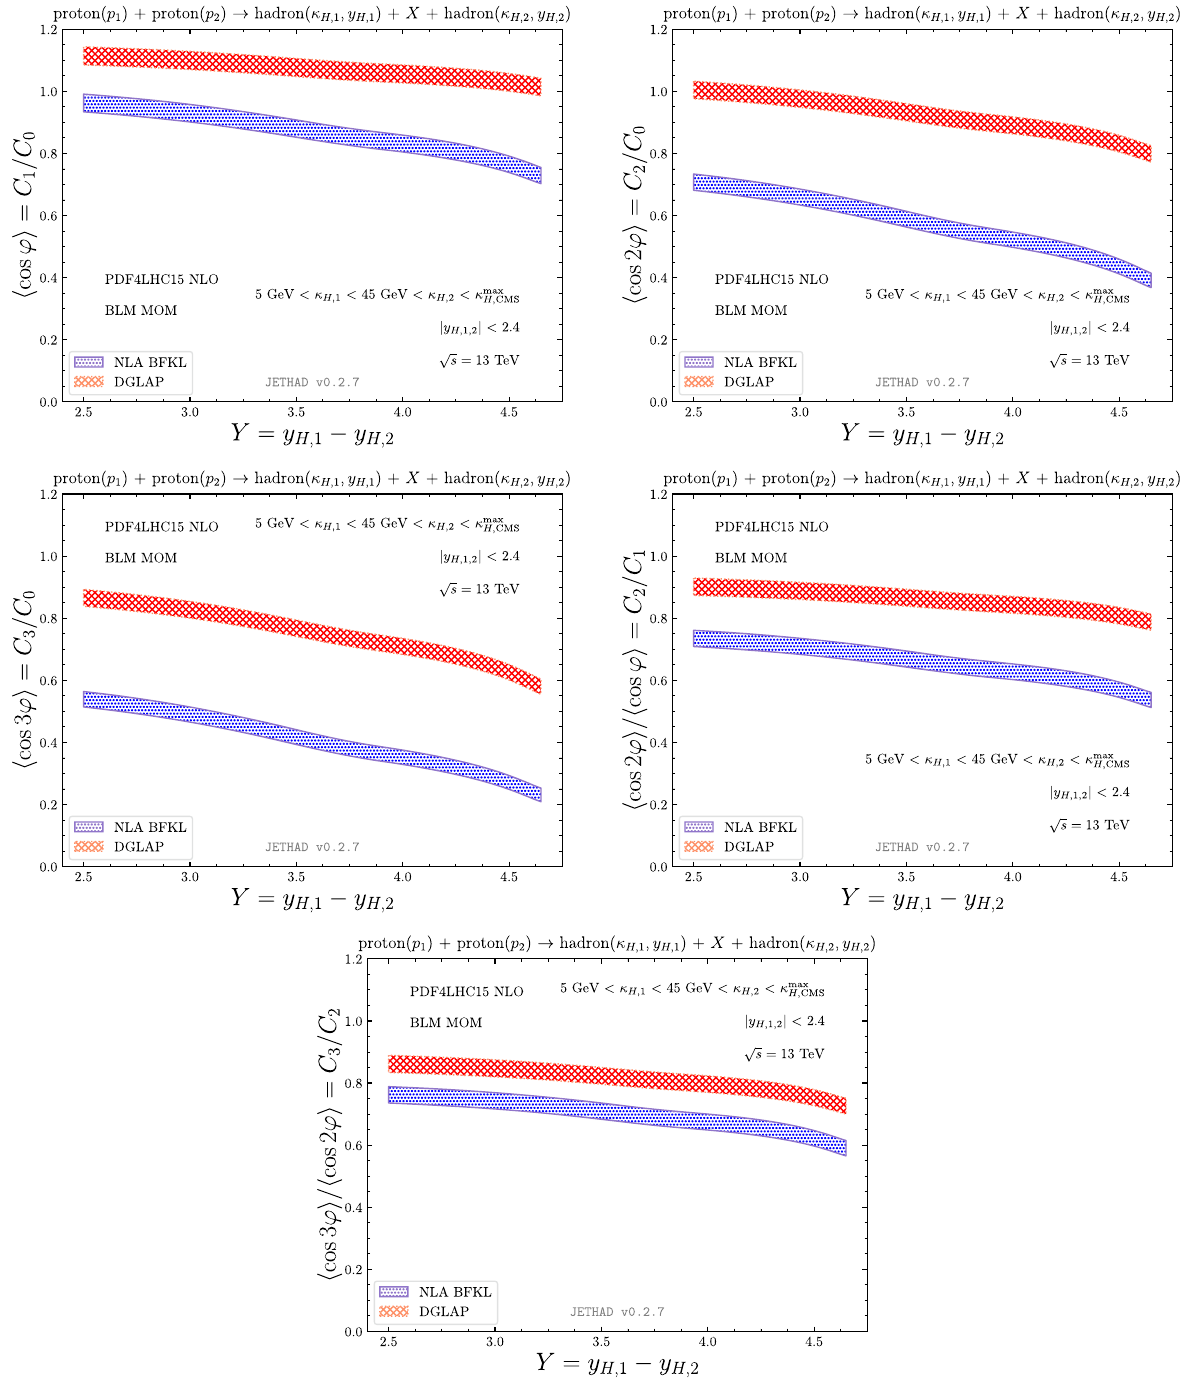
Fig. 15 Y -dependence of several azimuthal correlations, R nm ≡ C n / C m , of the inclusive di-hadron production (right panel of Fig. 2) √ s = 13 TeV ( asymmetric CMS config- for μ F 1 , 2 = μ R = μ BLM and R